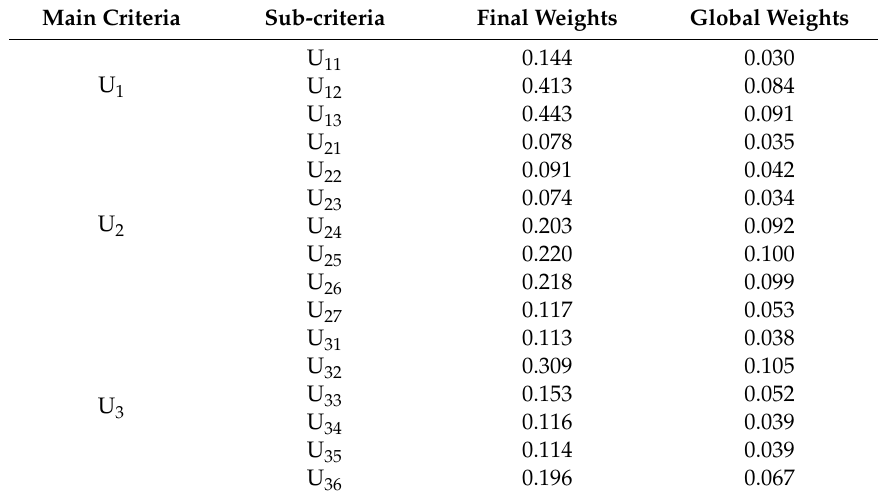
Table 11. The global weights of sub-criteria.